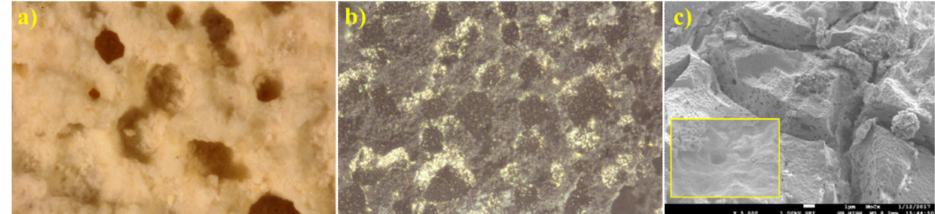
Figure 17. Microphotographs of the samples at 6.3 × magnification for ( a ) foamed AZF support, ( b ) carbided AZF composite, and ( c ) detailed structure of the carbide layer made by SEM (5000 × and 100,000 × ).